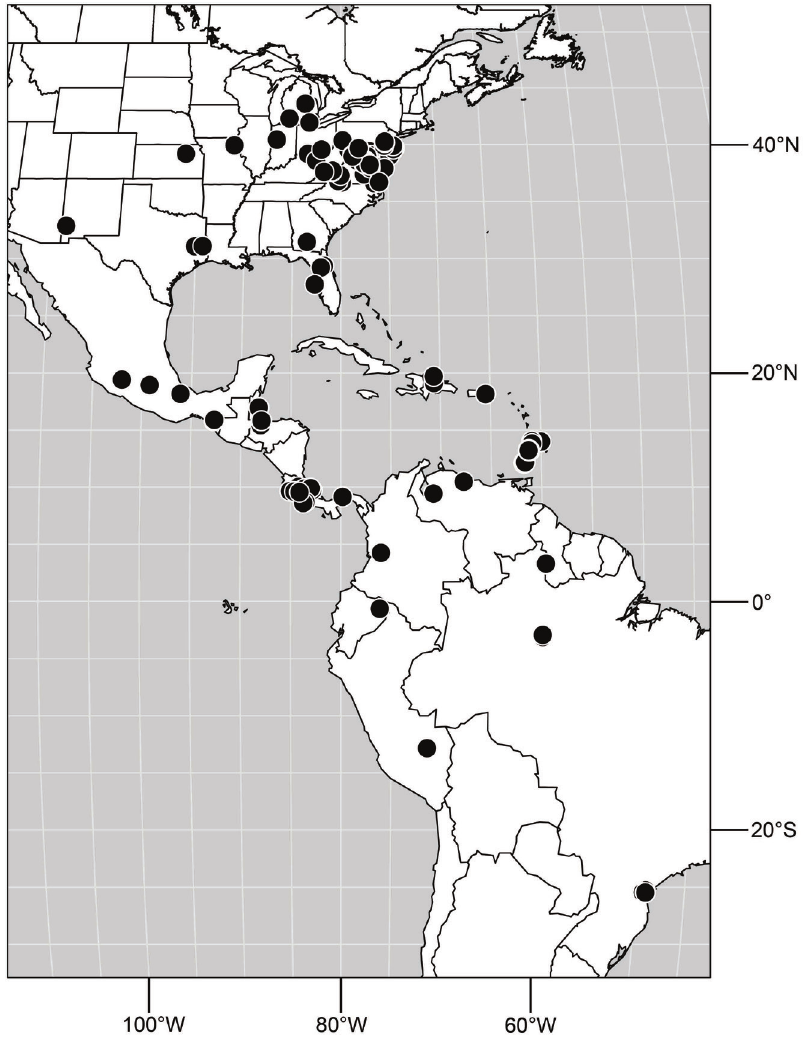
Figure 179. Distribution of Hydrochasma leucoproctum (Loew)